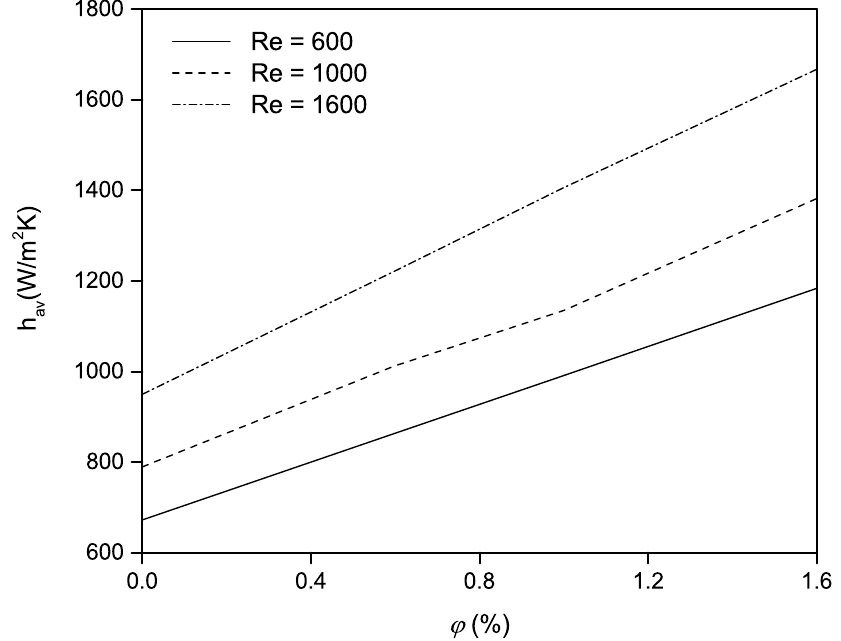
Figure 7. Effects of the Al 2 O 3 nanoparticle concentration ϕ and Reynolds number Re on the average heat transfer coefficient h av for d np = 42